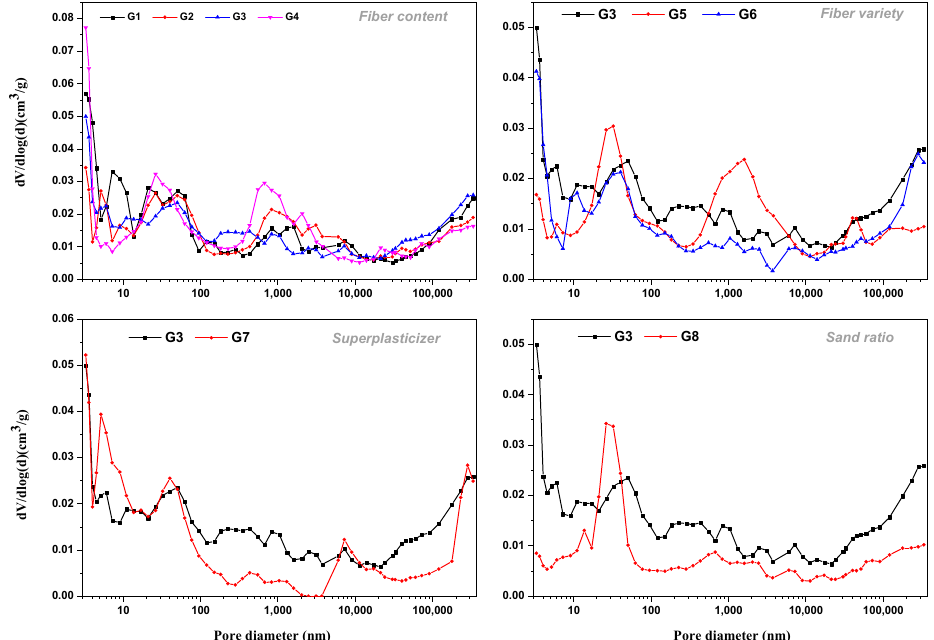
Figure 10. Size distribution of mercury injection voids in concrete.